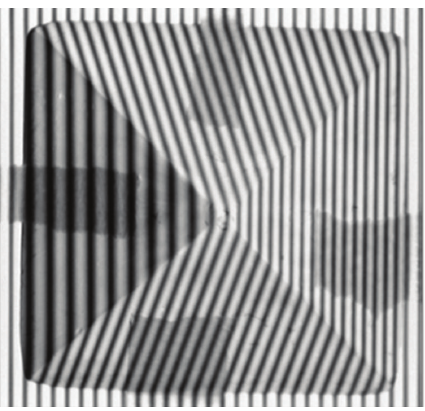
Figure 20: Fringe projection on the pyramid.